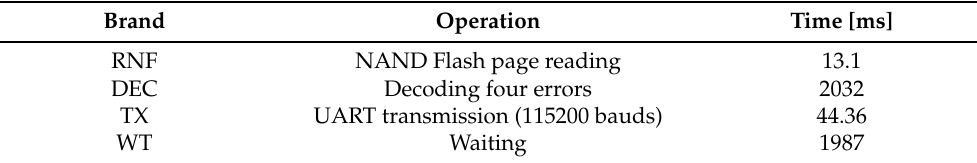
Table 5. Summary of times for reading NAND Flash at 115200 baud rate.